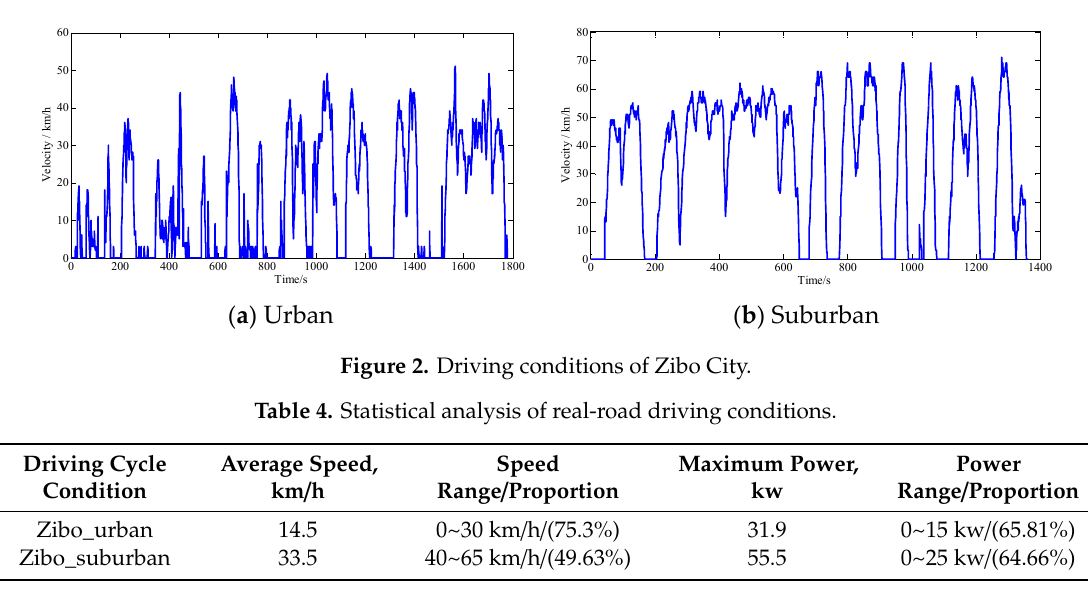
Table 3. Data statistics of typical vehicle driving conditions.